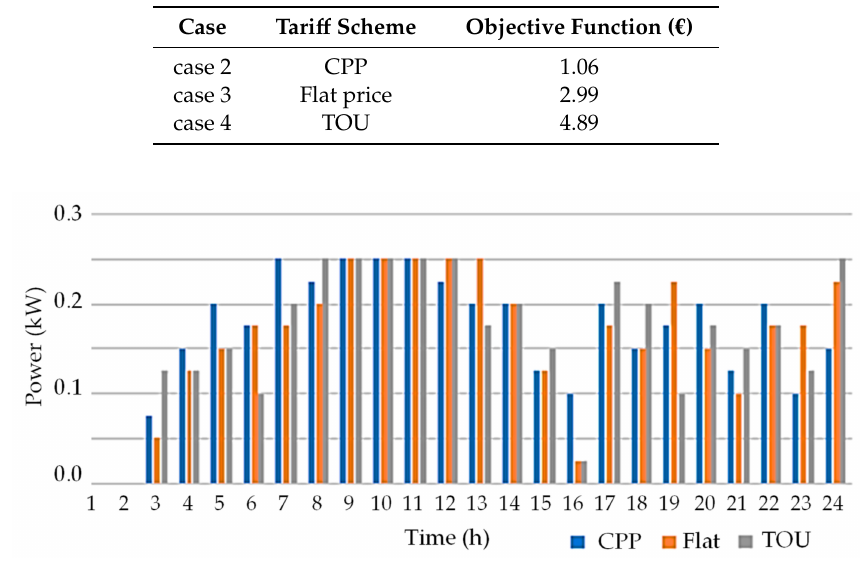
Figure14. Energyconsumedbytheheating, ventilationandairconditioningsystem: Comparisontari ff s.